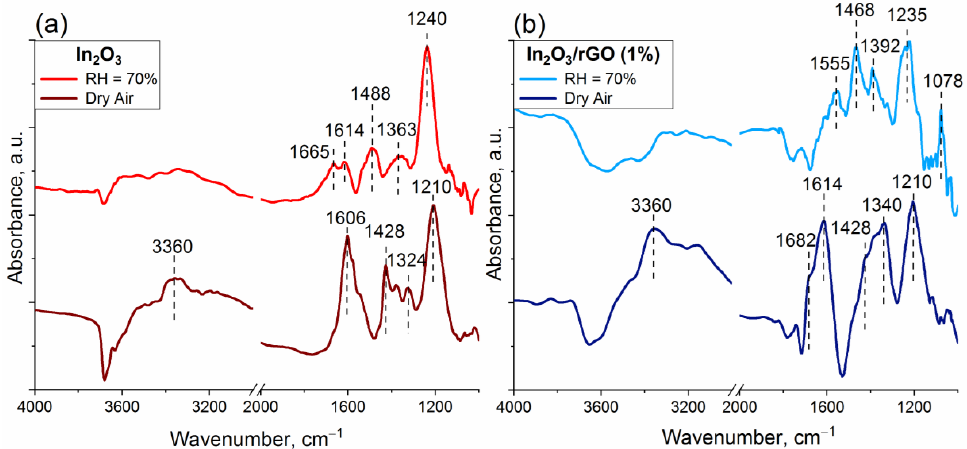
Figure 10. In situ DRIFT spectra of the In 2 O 3 ( a ) and In 2 O 3 /rGO (1%) ( b ) samples after 100 ppm NH 3 adsorption for 50 min at room temperature in dry air and humid air (RH = 70%). After 5 min of NH 3 exposure, narrow peaks in the range of 1210–1240 cm − 1 were immediately detected. These bands were assigned to NH 3+ species adsorbed on Lewis acid sites. An additional confirmation may be offered by the appearance of N-H stretching vibrations at the wavenumber of 3360 cm − 1 related to NH 3+ species under an atmosphere of dry air. The appearance of bands in the range of 1428–1488 cm − 1 was associated with NH 4+ species as a result of ammonia adsorption on Brønsted acid sites, including terminal In-OH groups. Such adsorption was accompanied by a decrease in the intensity of the bands of OH groups